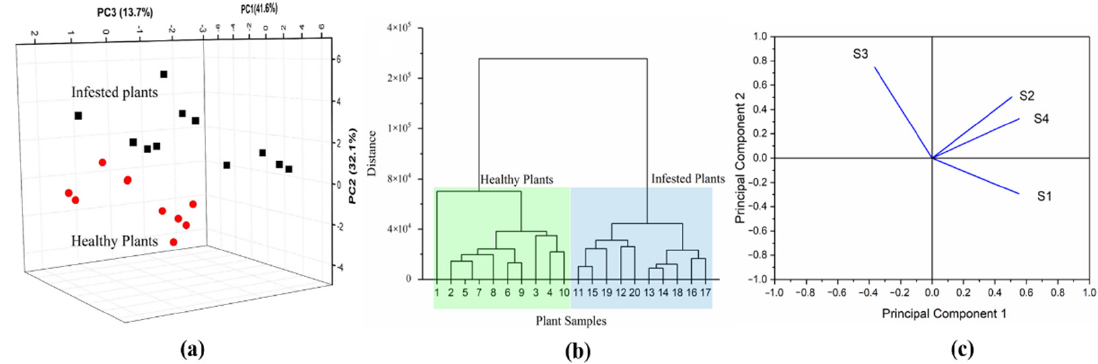
Figure 5. PCA result ( a ) and HCA result ( b ) of the developed E-nose system detecting healthy and infested tomato plants; PCA loading plot ( c ).